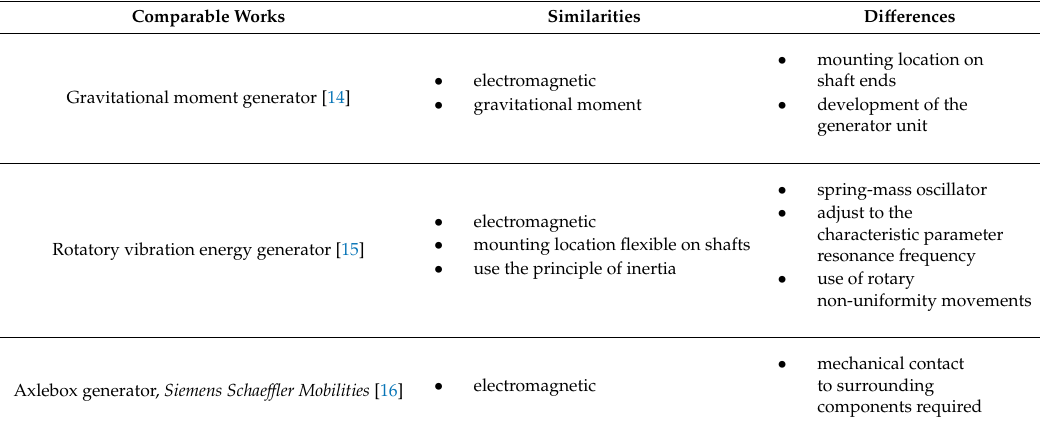
Table 1. Comparable works and their similarities and di ff